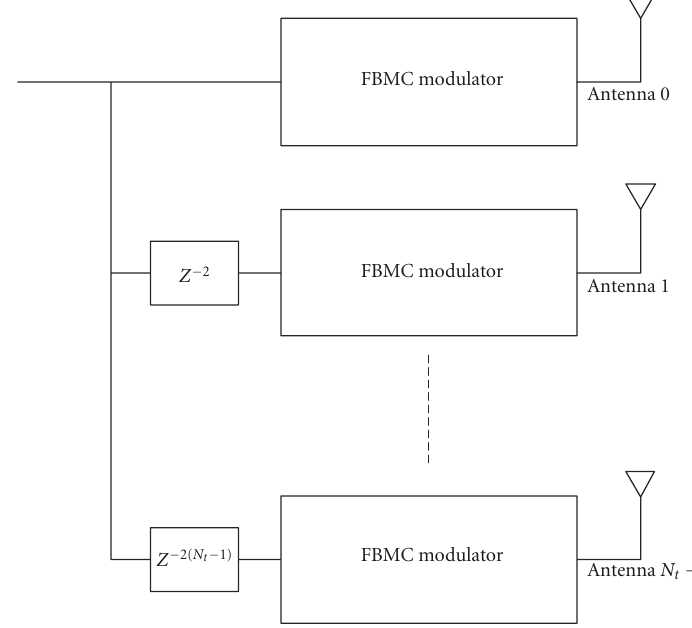
Figure 1: FBMC Single-delay STTC transmitter.